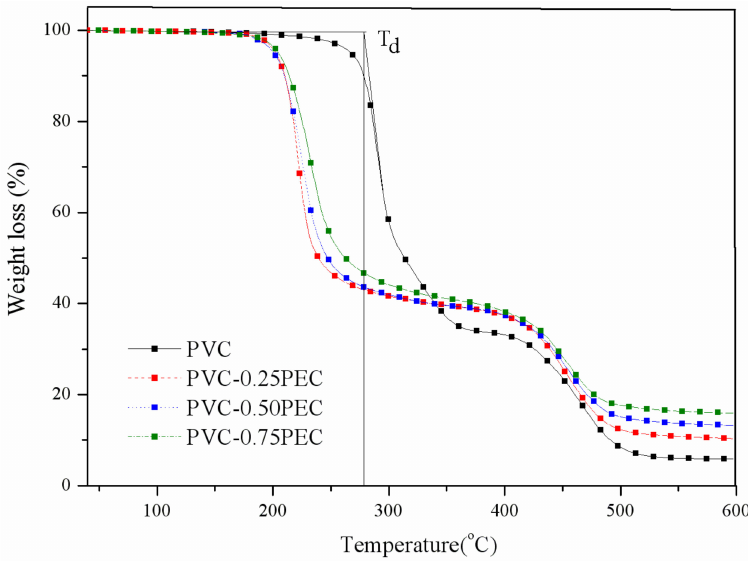
Figure 6. TGA curves of PVC and internally plasticzied PVC